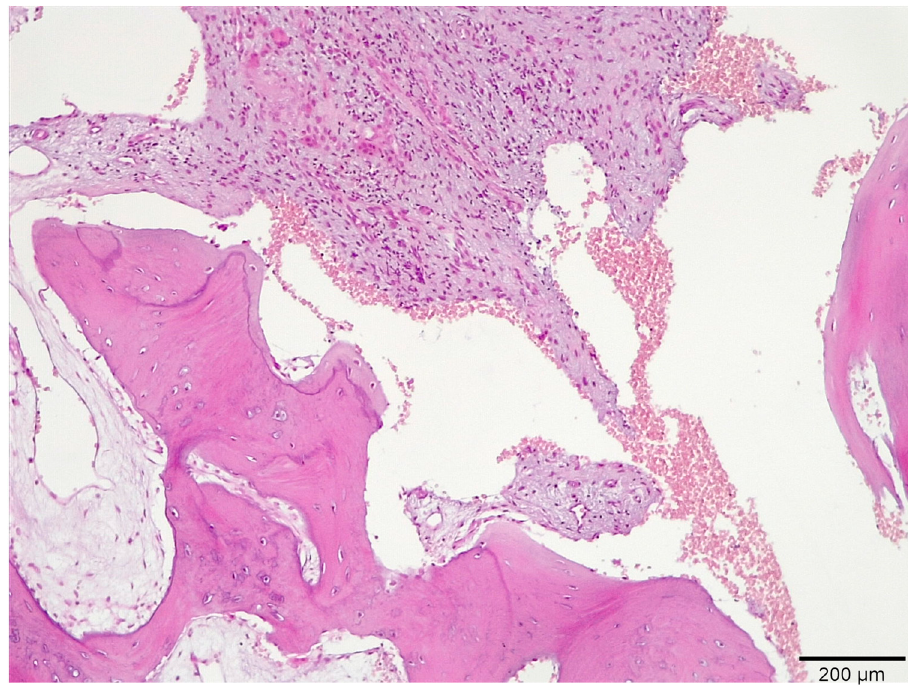
Figure 7. Histologic image at twelve months with high immature bone around dentin particles.